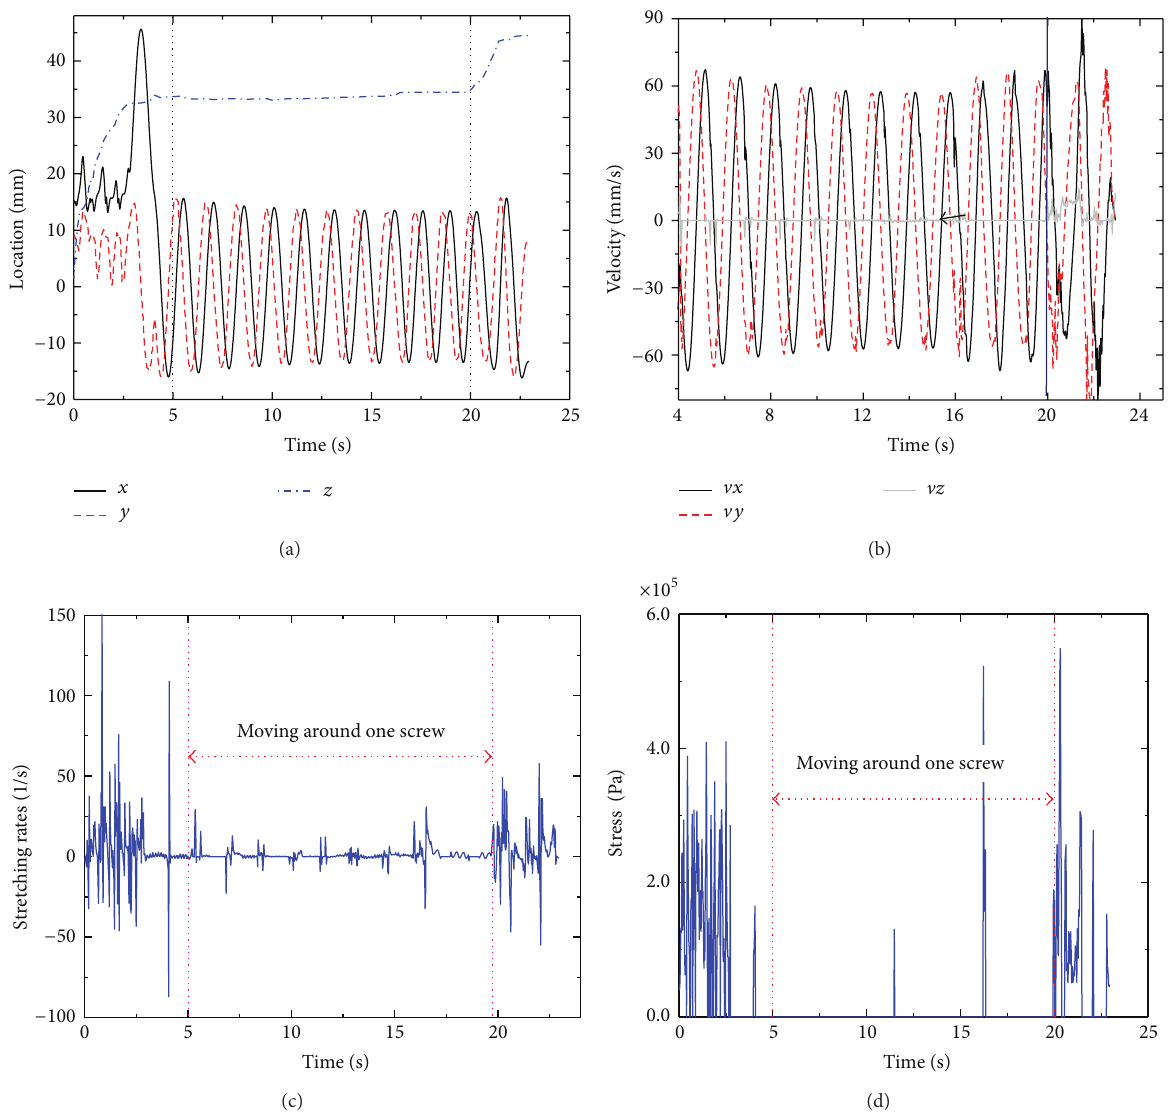
Figure 4: Periodical behaviors of Particle 2 in the tri-screw extruder: (a) displacement; (b) velocity; (c) stretching rate; (d) stress.